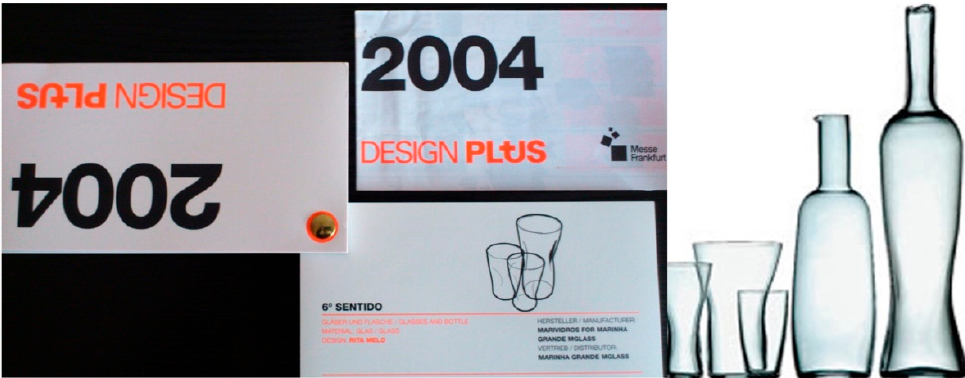
Figure 6. Rita Melo, 6 sence collection, Design Plus award, 2004. Photo credit: Rita Melo, designer; piece from Vitrocristal; catalogue image from Ambiente (Frankfurt)—Messe Frankfurt.